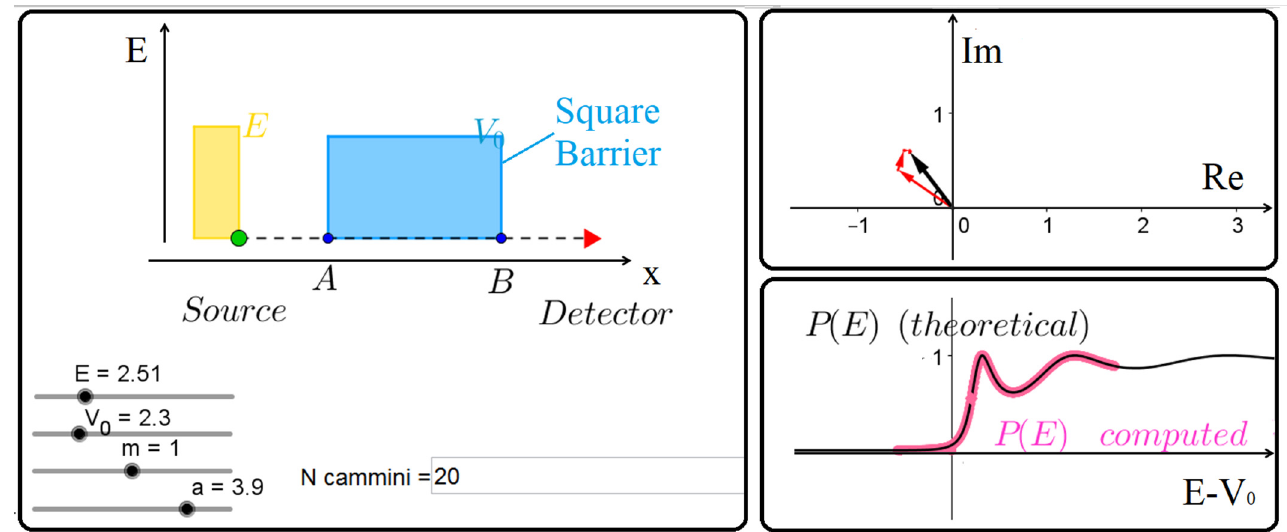
Figure 3. Partial snapshot of the simulation of square barrier tunneling for a massive particle in the framework of the time-independent sum over paths approach. Left: the green dot represents the source and the red triangle the detector. The yellow rectangle represents the incoming particle energy, as compared to the barrier energy (light blue). m is the particle mass in natural atomic units (so m = 1 is the electron mass). The word ‘cammini’ stands for ‘paths’ in Italian. Top right: the representation of the sum of amplitudes (in this case the amplitudes of paths reflecting inside the barrier have progressively lower absolute value as the number of internal reflections increases). The red arrows indicate the amplitudes associated to individual paths, which are summed to form the final amplitude (black arrow). Bottom right: the probability, 𝑃(cid:4666)𝐸(cid:4667) , of revealing the quantum object at the detector beyond the barrier (transmission probability) as a function of the difference between the particle energy and the barrier height, compared to the theoretical formula. In the typical structure of a teaching-learning sequence based on the sum over paths approach (e.g., Ref. [18]), the topic of tunneling is treated before bound systems and en- ergy quantization, with the case of the resonant scattering of a photon between two semi-reflecting mirrors (Figure 4) playing the role of a transition case between open and bound systems. Figure 4. Partial snapshot of the simulation of resonant scattering between two semi-reflecting mirrors for a photon in the framework of the time-independent sum over paths approach. Left: the setup with the green dot representing the source and the red triangle the detector. The green arrow represents the wavelength of the photon directed towards a system of two semi-reflecting mirrors. Right: the probability of detecting the photon at the detector beyond the mirrors as a function of